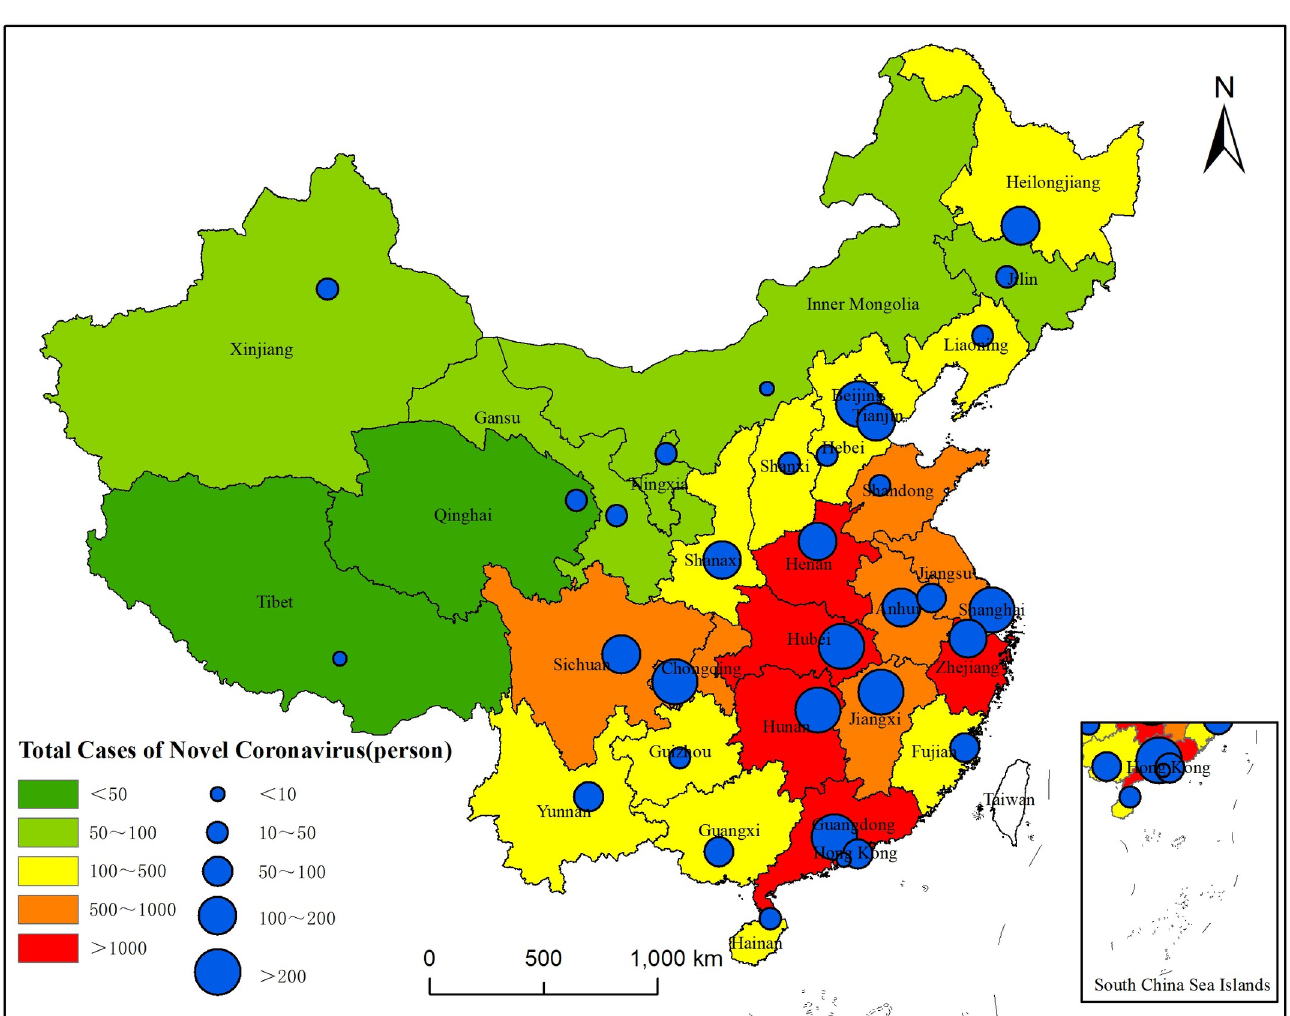
Fig 1. Distribution of the total number of confirmed cases of COVID-19 in provinces, municipalities and capital cities (statistics as of March 6, 2020).